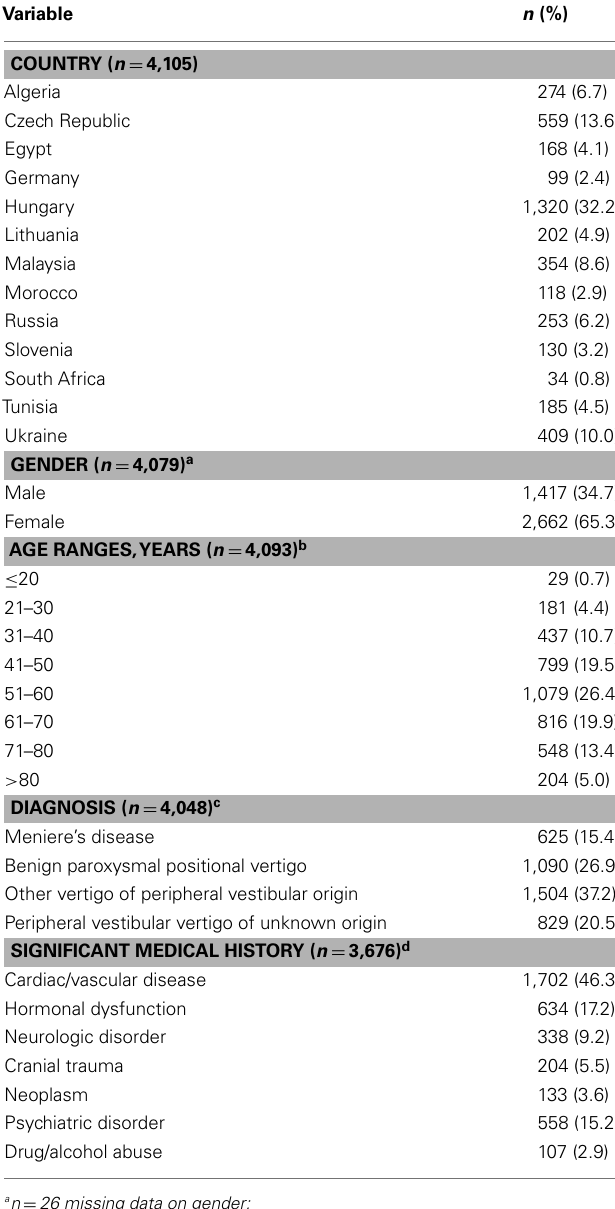
Table 1 | Study population in REVERT registry atVisit 1 ( n =